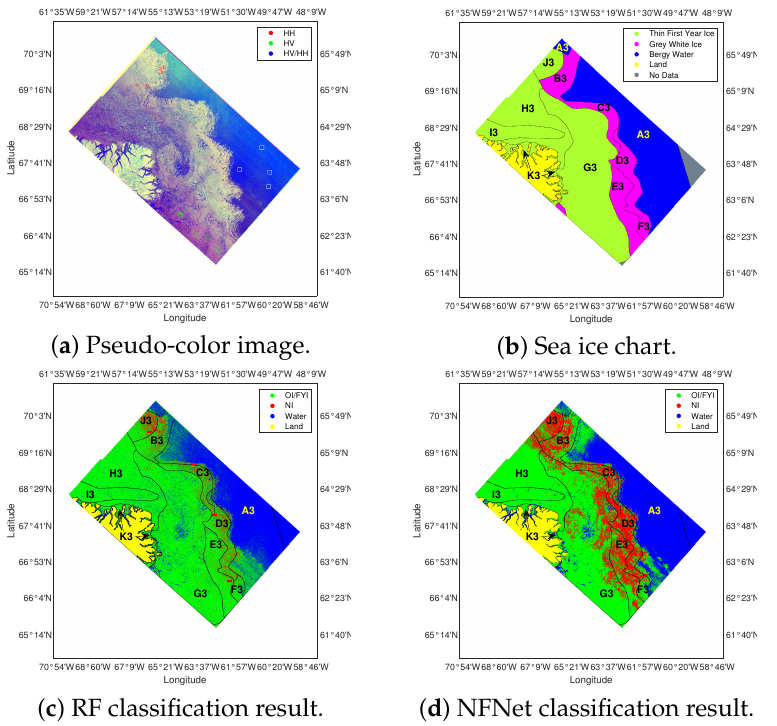
Figure 9. ( a ) Image acquired on 4 January 2021. The green, red and white rectangles indicate the areas of the testing samples of OI/FYI, NI and water, respectively. The testing samples were at least 100 kilometers away from the 1 March training samples. ( b ) Sea ice chart. The area without sea ice chart data is indicated in gray. ( c ) RF classification result. ( d ) NFNet classification